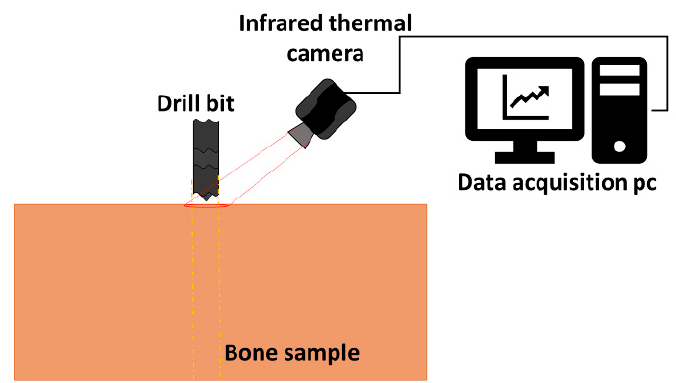
Figure 15. Temperature measurement using a thermal infrared camera [26].